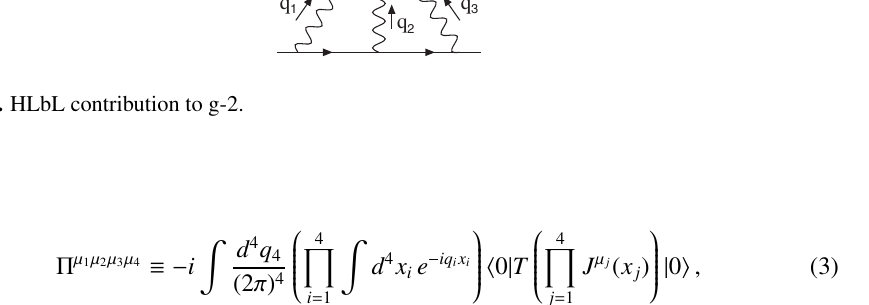
Figure 1. HLbL contribution to